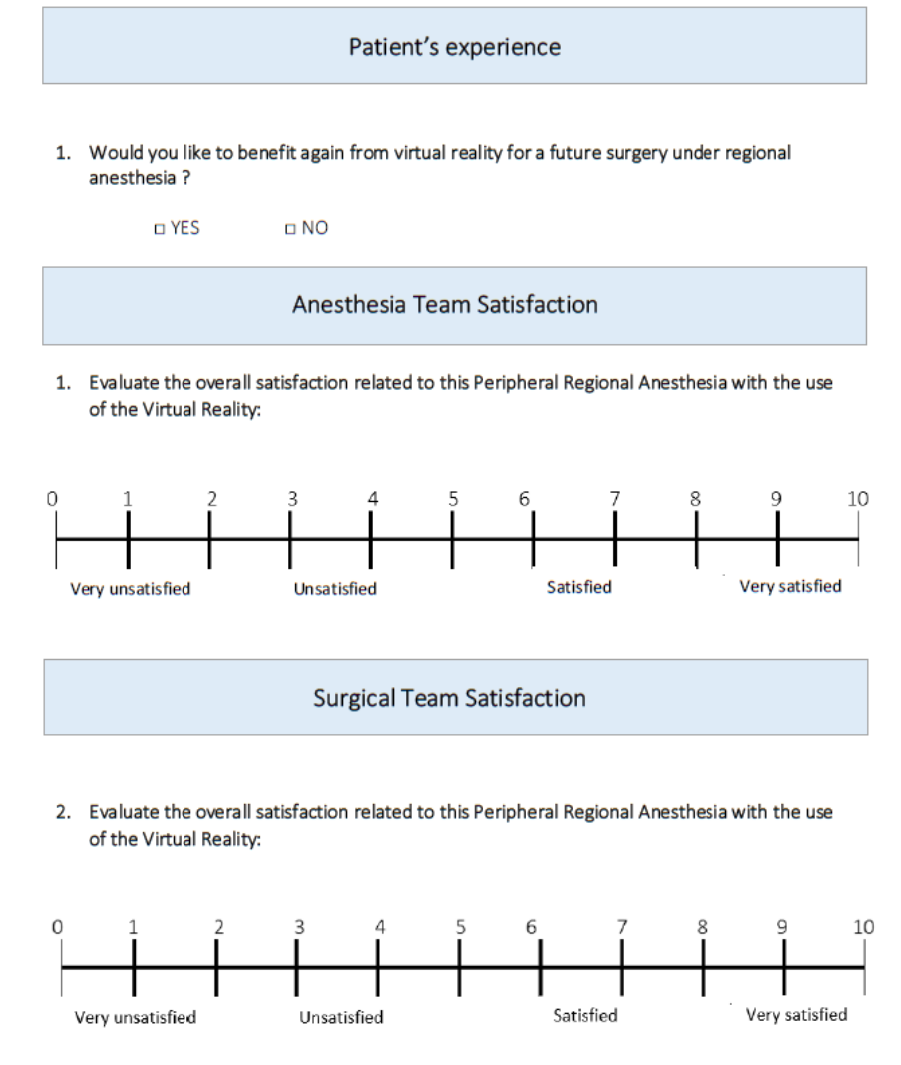
Figure A4. Virtual Reality Headset Tracking Sheet (2/2)